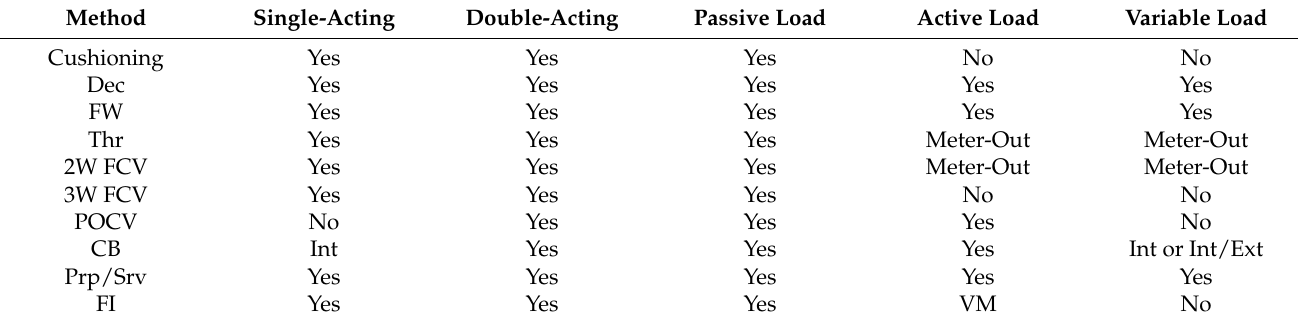
Table 1. Methods used in various types of actuator systems and loads acting on the piston rod.